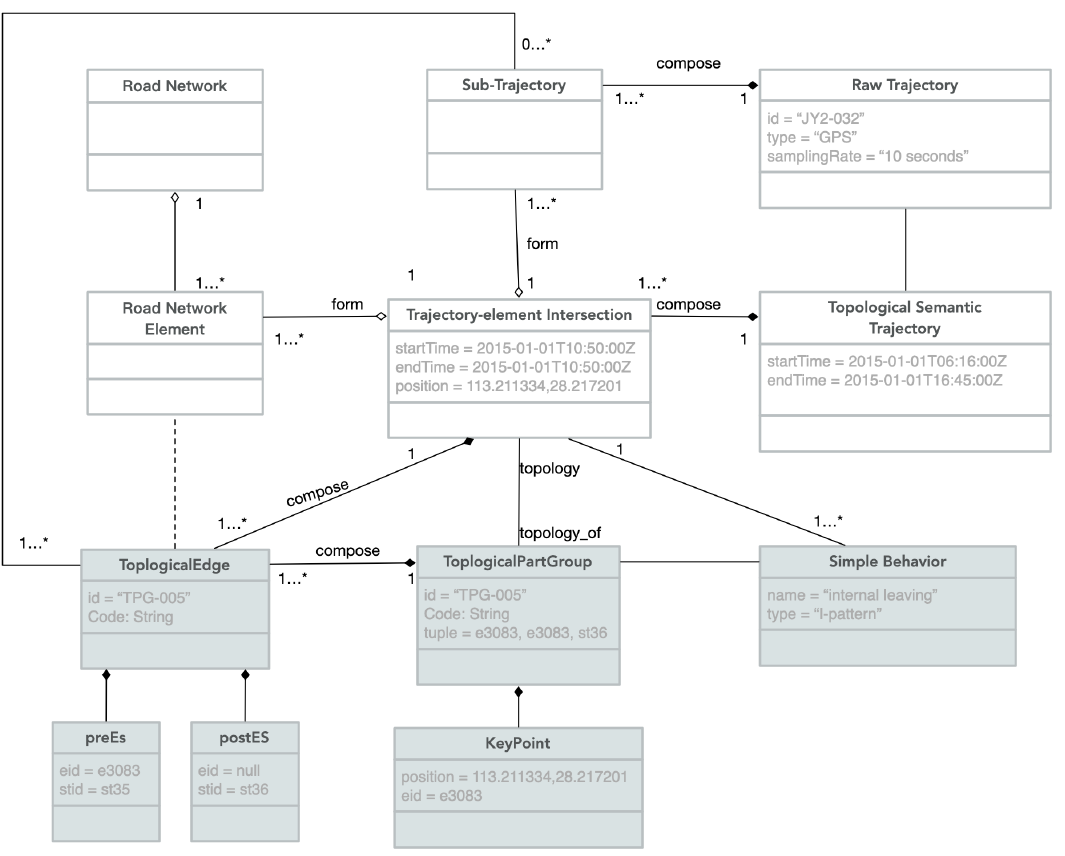
Figure 7. The instantiation for a commercial vehicle